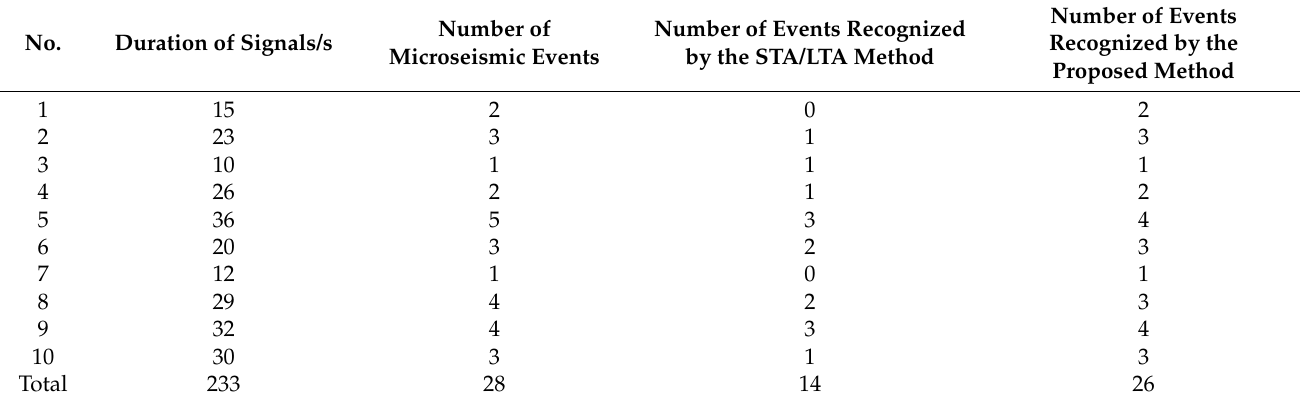
Table 2. Comparison of the two methods.